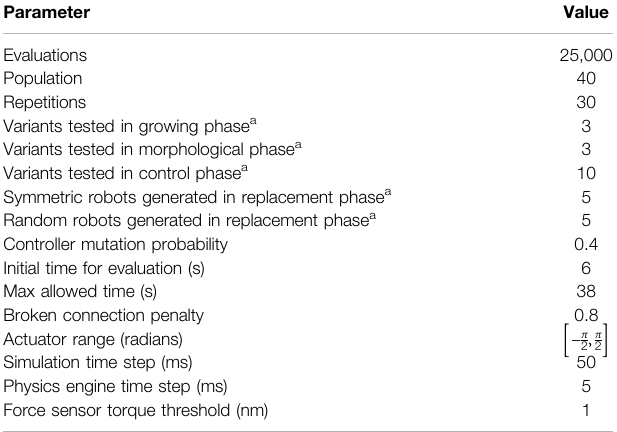
TABLE 3 | Simulation experiments